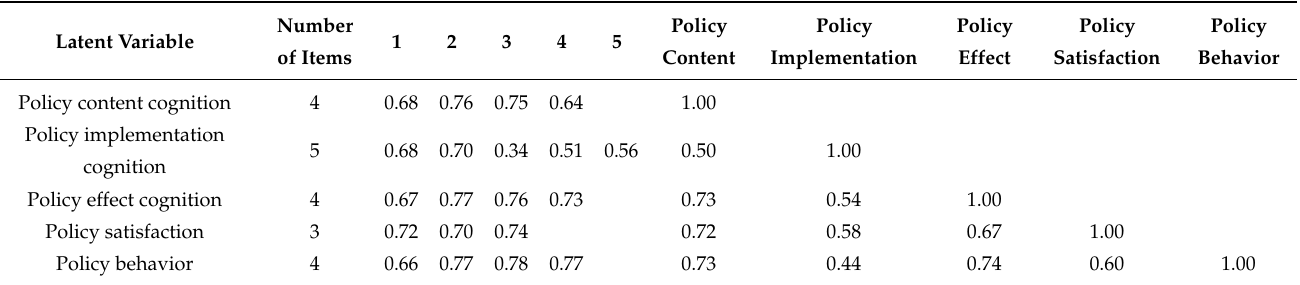
Table 2. Factor load value and correlation matrix of school sports policy attitude measurement